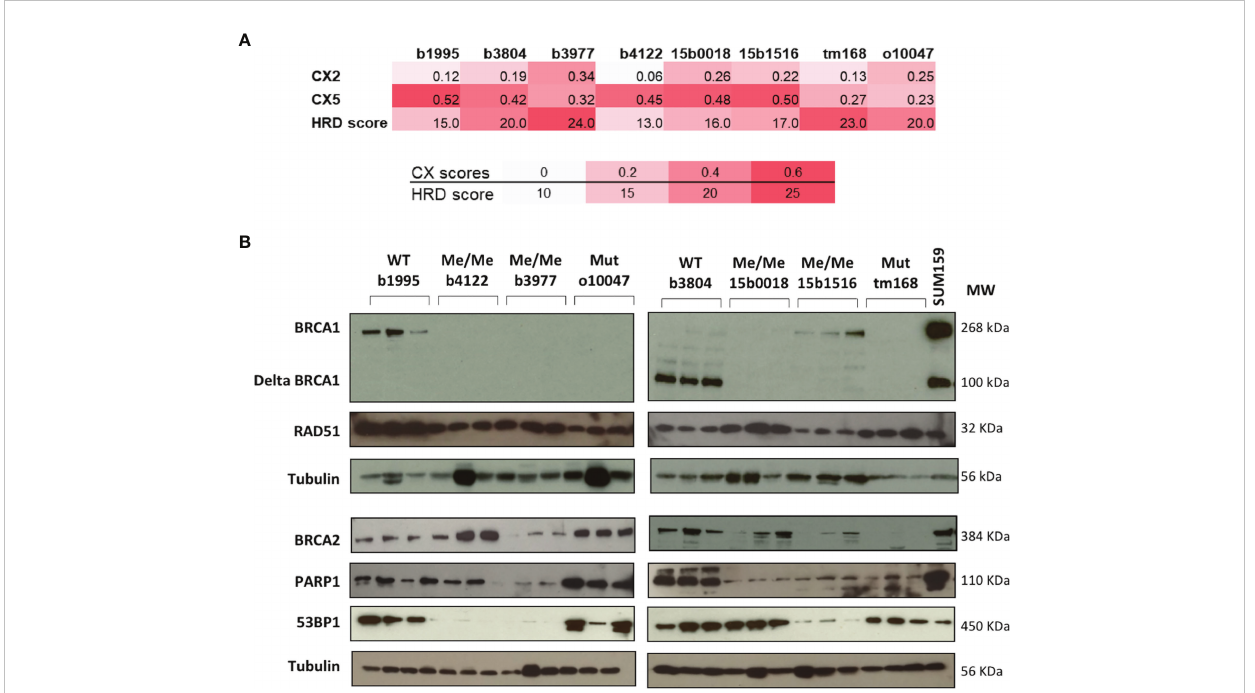
FIGURE 2 Principal characteristics related to HR of the PDX models. (A) CX Chromosomal instability and HRD scores of each PDX model. Color shades indicate from white to red the level of instability. (B) Protein expression patterns were assessed by Western blotting. The BRCA1 status of each model is indicated on top of the autoradiograms. WT wild type. Me/Me homozygous methylation. U/Me hemizygous methylation. Mut coding mutation. For each PDX model three independent extracts from individual PDX tumors were loaded and analyzed. Proteins analyzed are indicated on the left and Molecular Weights in KDalton on the right. The protein extract of SUM159 cell line extract was added to the BRCA1 panel to illustrate the full length and the D 11 BRCA1 protein